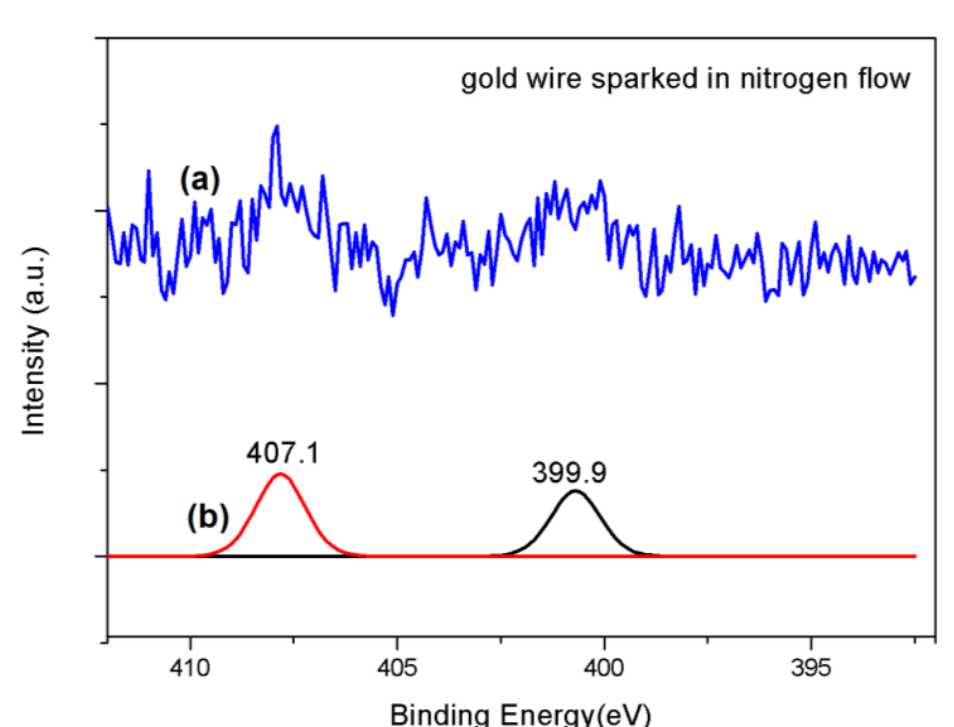
Figure 6. XPS N 1s spectra of thin films prepared in nitrogen flow: ( a ) blue—XPS spectra measured; ( b ) fitting of spectra.